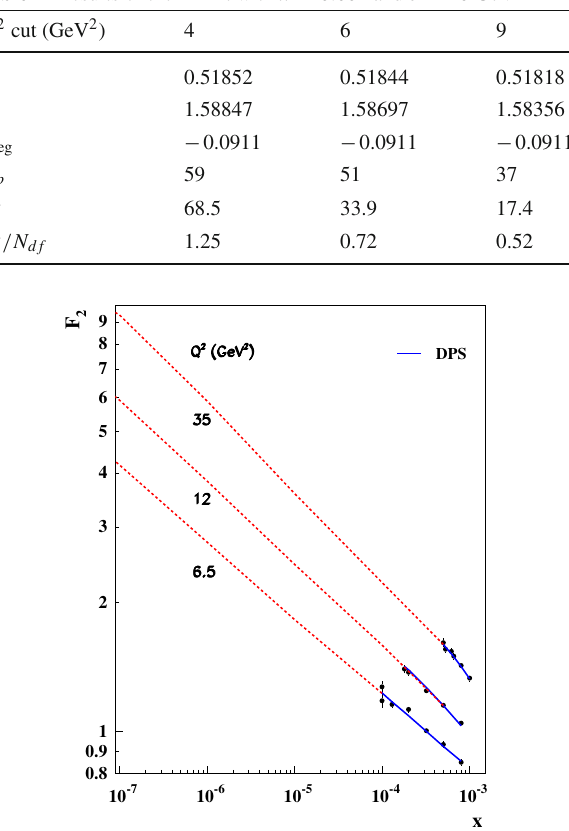
Fig. 16 Extrapolation of the AB fit results to very low